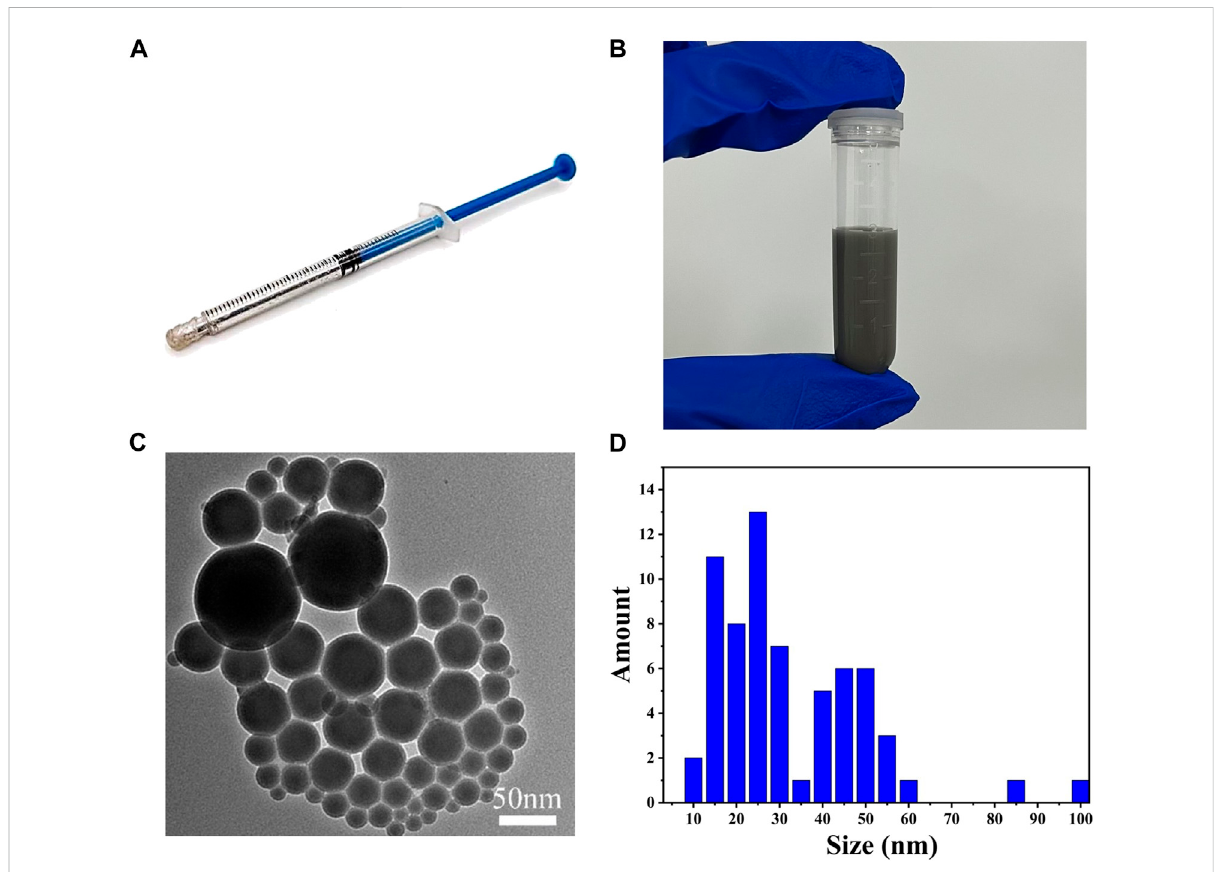
FIGURE 1 (A) GaInSn liquid alloy encapsulated in needle tubing. (B) As-prepared suspension of the GaInSn nanospheres. (C) TEM image. (D) The corresponding size